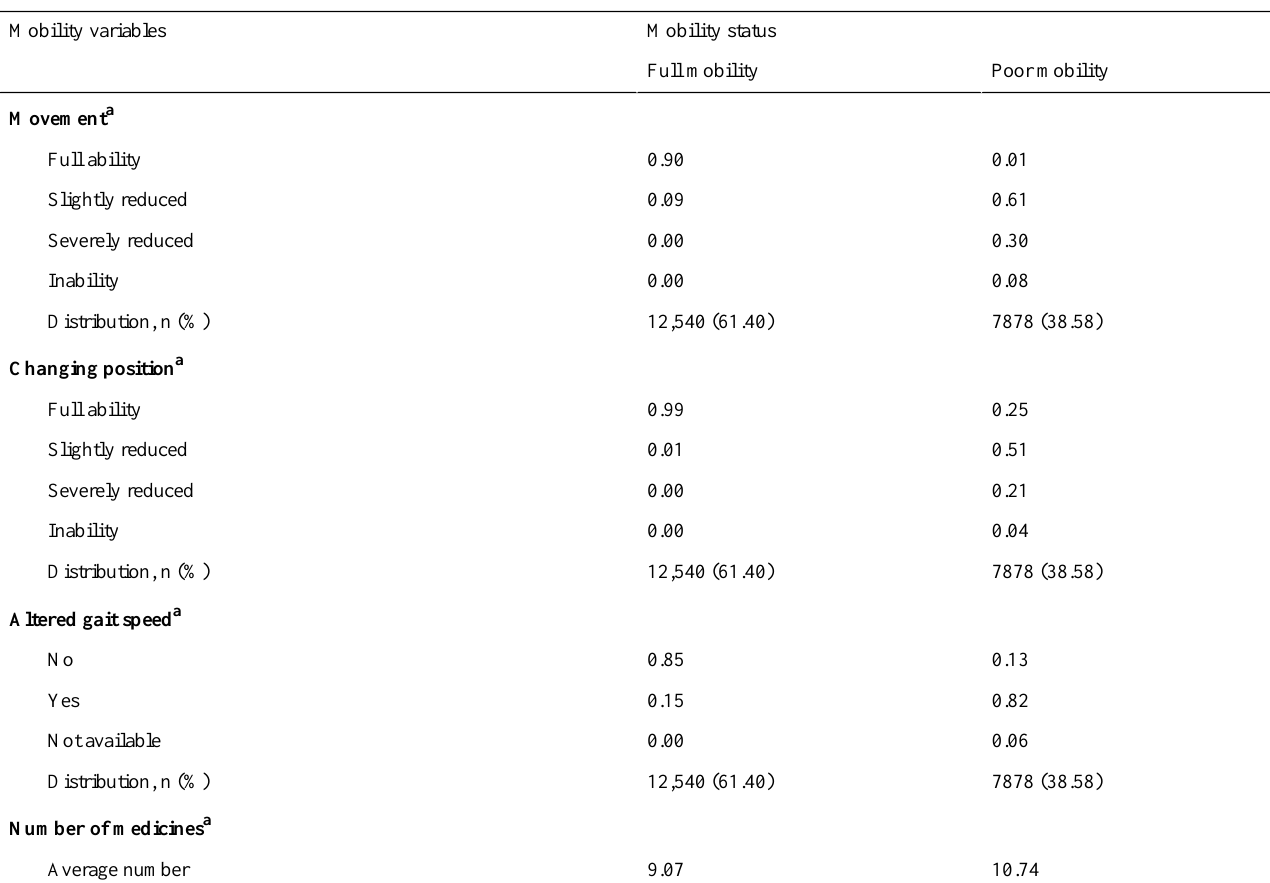
Table 3. Distribution of individuals in the 2-cluster solution for all mobility variables